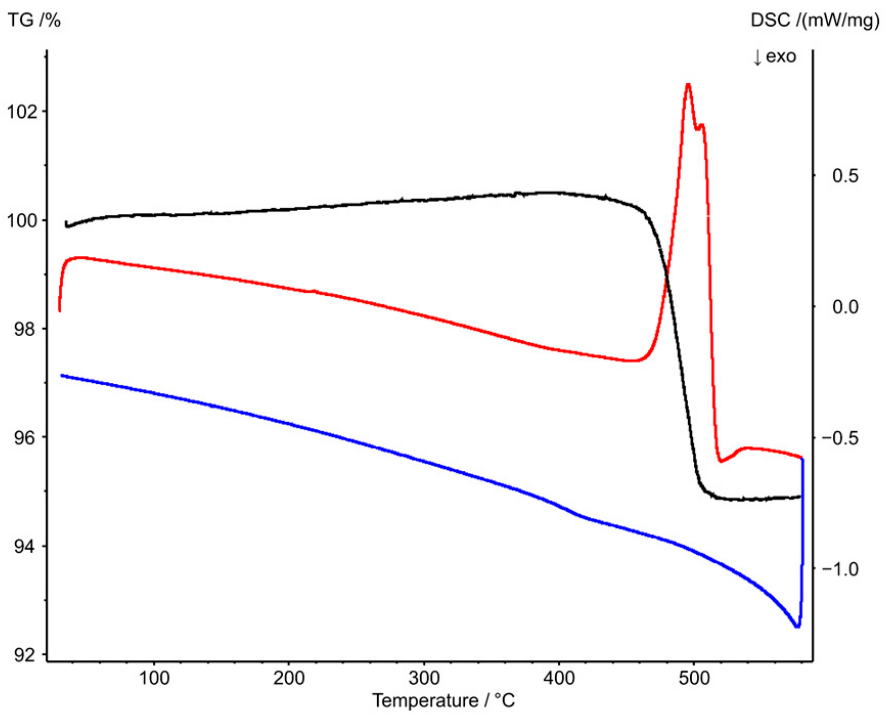
Figure 9. Co 2 (TeO 3 )(OH) 2 : TG curve (black) and DSC curves on heating (red) and cooling (blue).